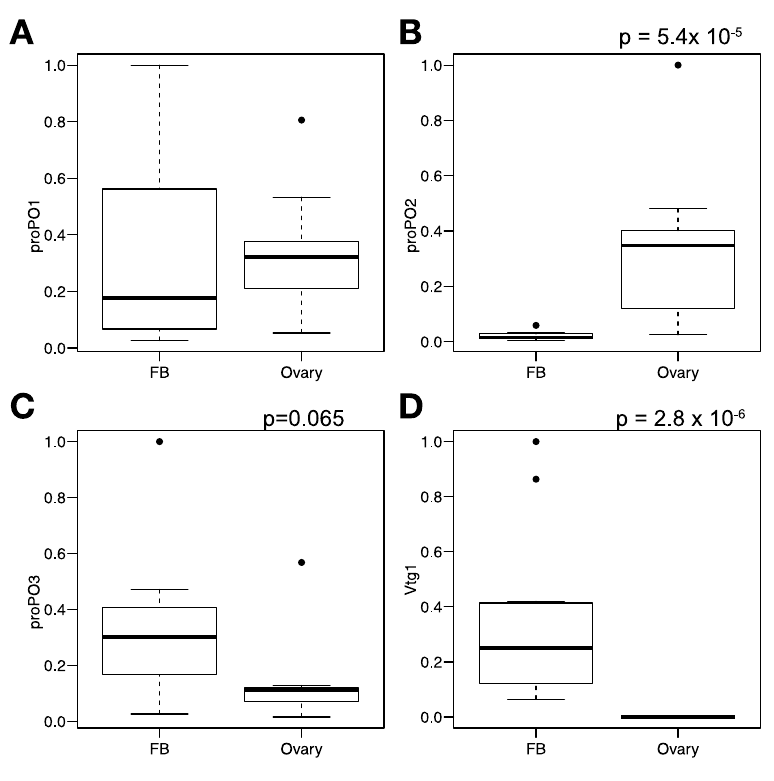
Fig 5. Ovaries produce phenoloxidase (PO) in the cricket. Gene expression levels of proPOs (A-C) and vitellogenin (D) were measured in the fat body and the ovaries. The values were normalized by two reference genes, and the relative expression levels (arbitrary units, where the maximum expression level is set at 1.0 for each transcript) are shown in the figure. The bars represents the 25 th and 75 th percentile, the central line in bold represents the median and the error bars denote the maximum and minimum values for each group. Outliers plotted as dots. Statistical information is described in the Results section. The sample size (biological replicates) is N = 11. FB: Fat Body.